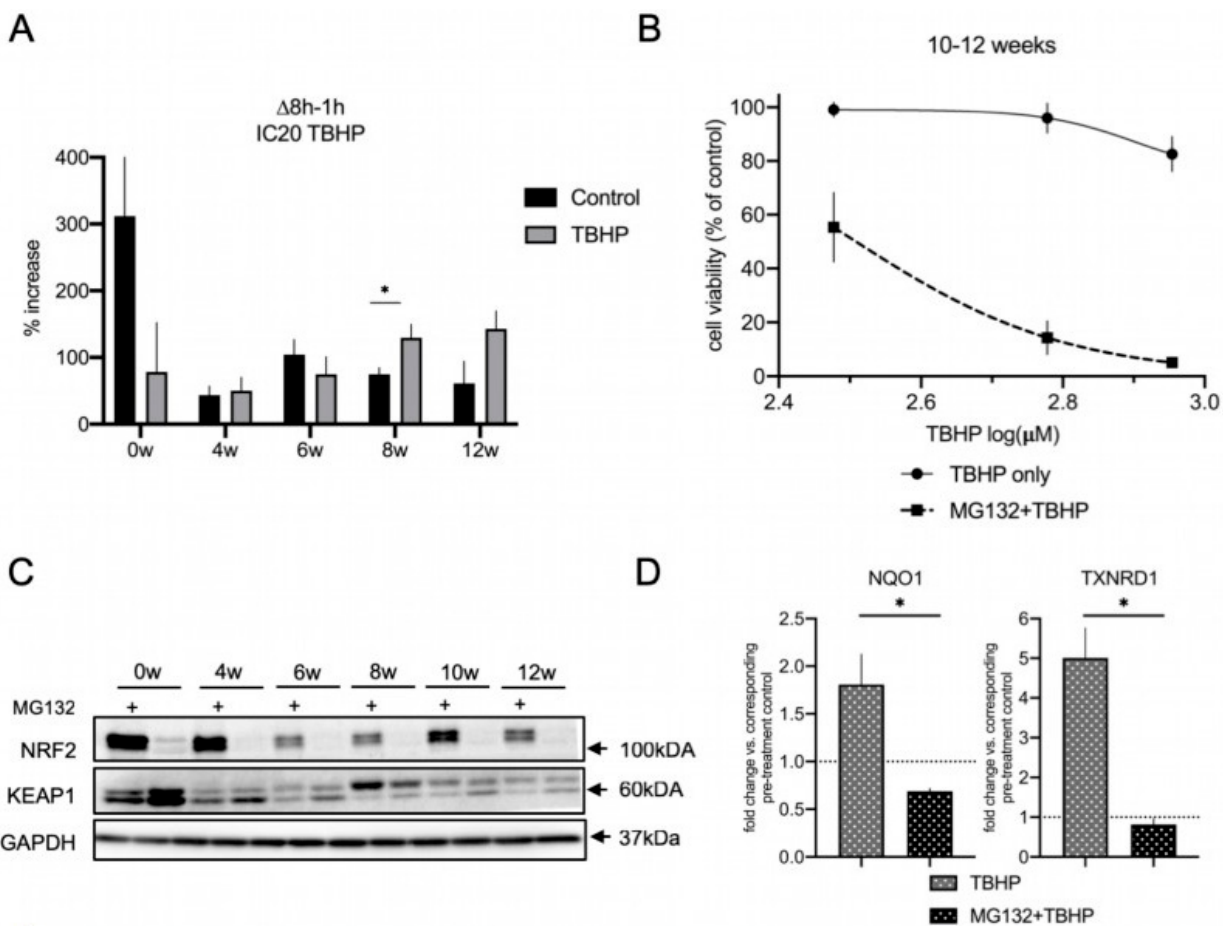
Figure 6. The proteasome is a major contributor to the acute oxidative stress response in differentiating lt-NES cells and regulates NRF2 pathway activation. ( A ) Measurement of the 20S proteasome activity in proliferating and differentiated lt-NES cells. The proteasomal substrate dye LLVY-R110 was added to the cells together with IC20 TBHP concentrations, and fluorescence was measured after 1 h and 8 h. Proteasomal activity is presented as percentage increase in the fluorescence signal between 8 h and the baseline value at 1 h ( ∆ t-t1h). Data are presented as means ± SEM ( n = 4 per treatment and differentiation time point, * p < 0.05, Student’s t-test). ( B ) ATPlite assay of lt-NES cells differentiated for 10 and 12 weeks treated with TBHP with or without MG132 pre-treatment, showing that proteasomal impairment leads to increased susceptibility to acute oxidative stress. Cells were pre-treated with MG132 followed by a 24 h TBHP treatment. Cell viability was assessed at the end of the treatment by ATPlite assay. Results are presented as percentages relative to untreated cells (equal to 100%). Data are presented as means ± SEM ( n = 5, consisting of at least 3 technical replicates per treatment condition; data from the control curve are the same as shown in Figure 5D). Significant difference between dose–response curves for TBHP treatment with or without MG132 was confirmed by two-way ANOVA ( p < 0.0001). ( C ) Western blot analysis of NRF2 and KEAP1 protein levels across lt-NES differentiation upon proteasomal inhibition (by MG132) for 17 h. ( D ) NRF2 pathway downstream target gene expression under OS induction upon inhibition of the proteasome (MG132). lt-NES cells were differentiated for 10 weeks, pre-treated with MG132 for 17 h and subsequently treated with TBHP for 8 h. Cells were treated with TBHP only for 8 h as a control treatment. Expression of the NRF2 downstream target genes NQO1 and TXNRD1 was analyzed by qRT-PCR. Results are presented in comparison to MG132 pre- treatment control (equal to 1). Data are normalized to GAPDH mRNA levels and presented as means ± SEM ( n = 4 per treatment condition). Statistically significant difference between means was